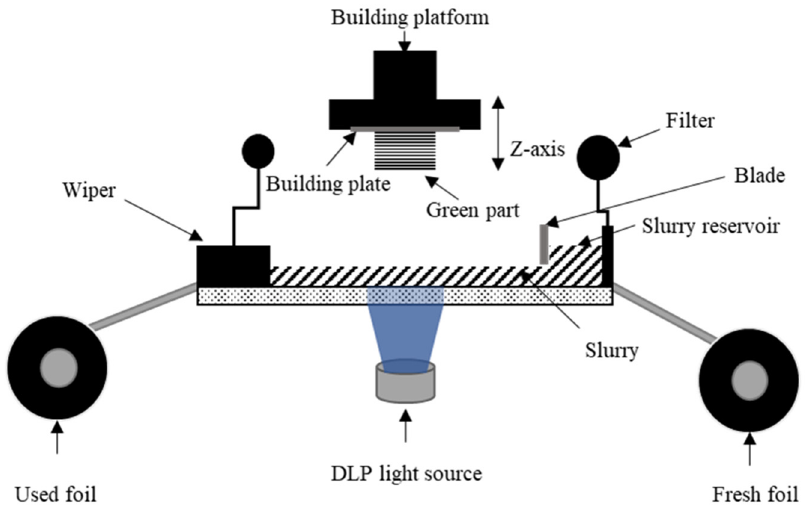
Figure 3. Schematic of the Admaflex 130 printer.